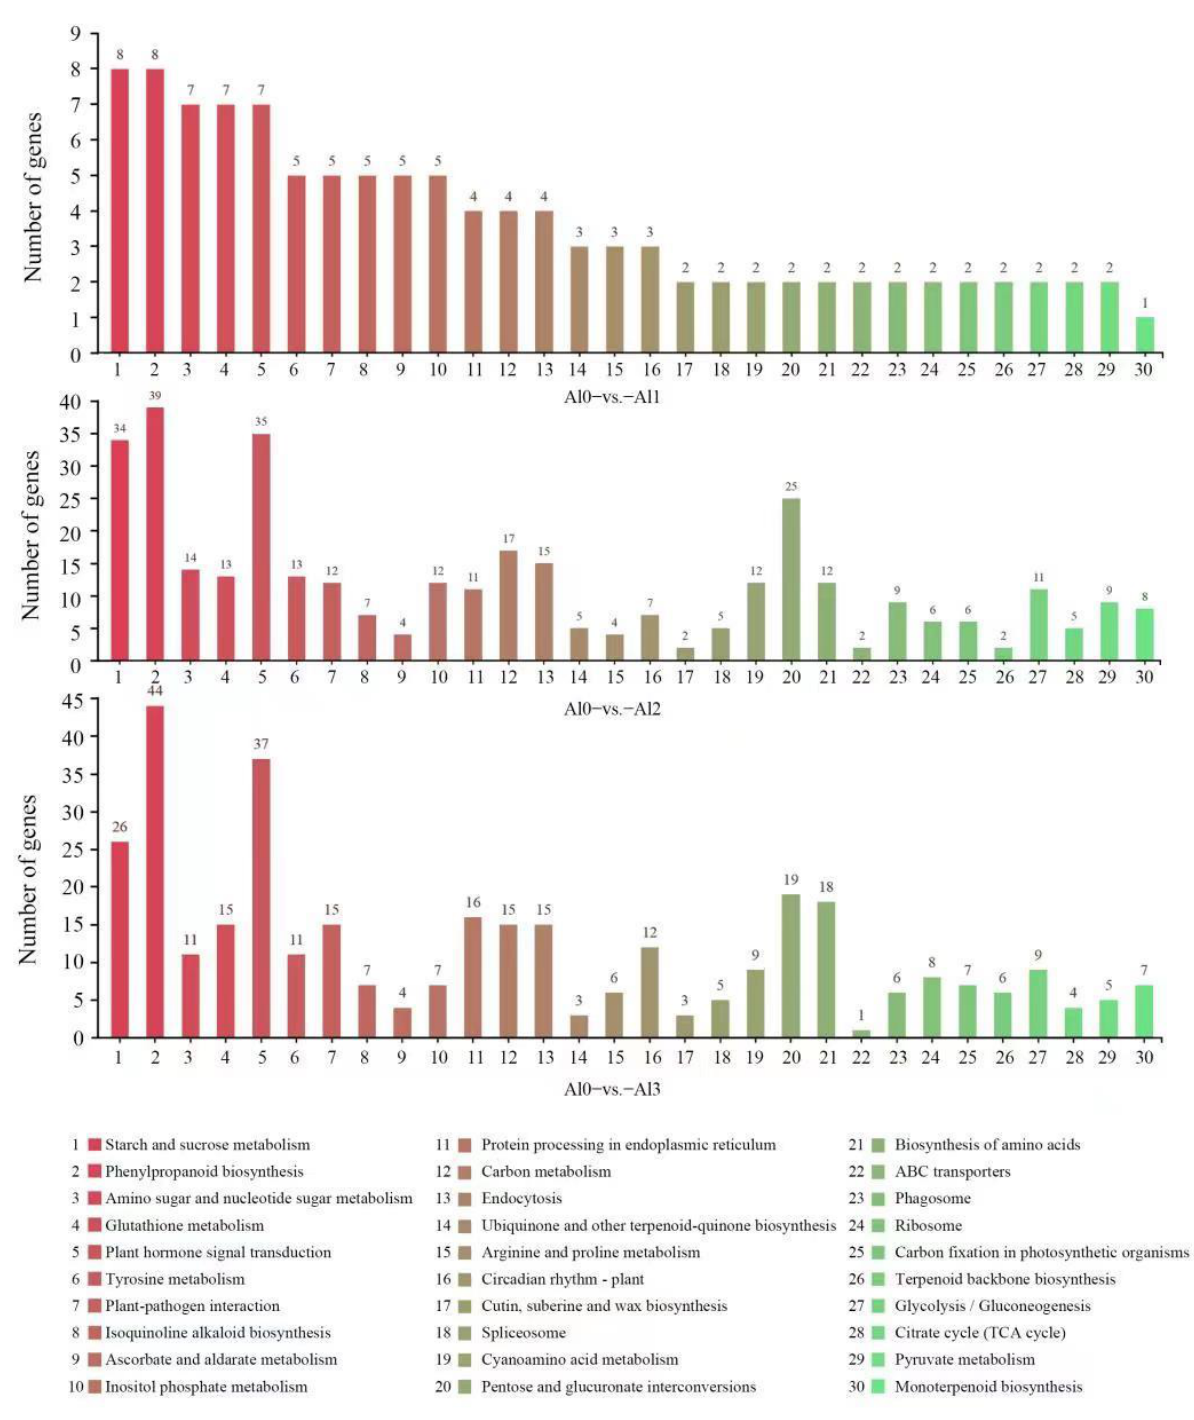
Figure 3. Regulations of the KEGG pathway. Al0, Al1, Al2, and Al3 represent 0 (pH 6.85), 1.25 (pH 4.03), 2.5 (pH 3.85), and 5 (pH 3.69) mmol/L AlCl 3 .18H 2 O solutions, respectively. Different colors represent different biological processes, and numbers represent the number of DEGs in the same biological process under different Al treatment